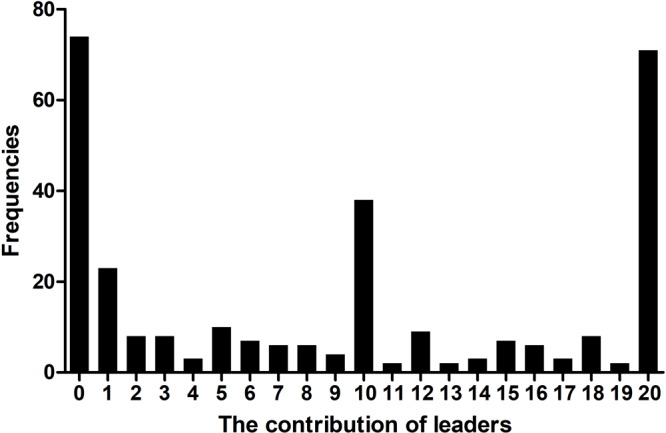
The contributions of the leaders in pilot study.